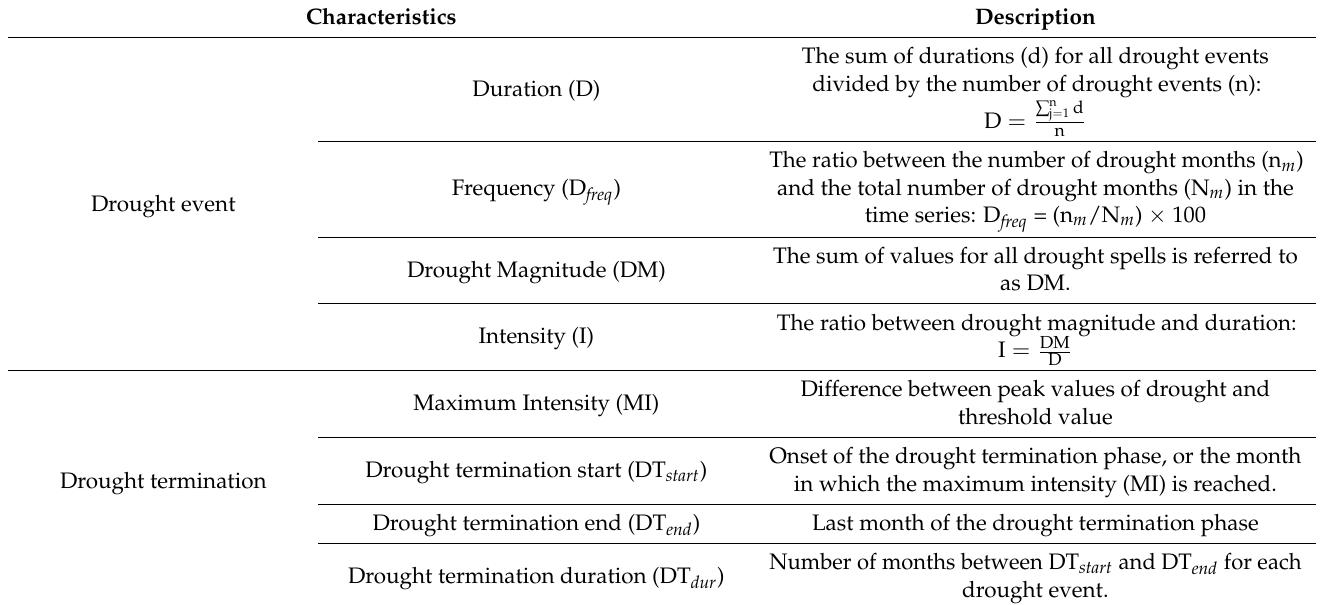
Table 1. Summary of drought event and termination